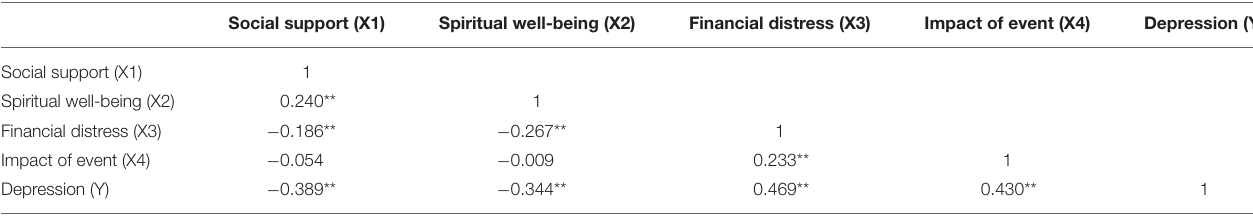
TABLE 2 | Correlations between